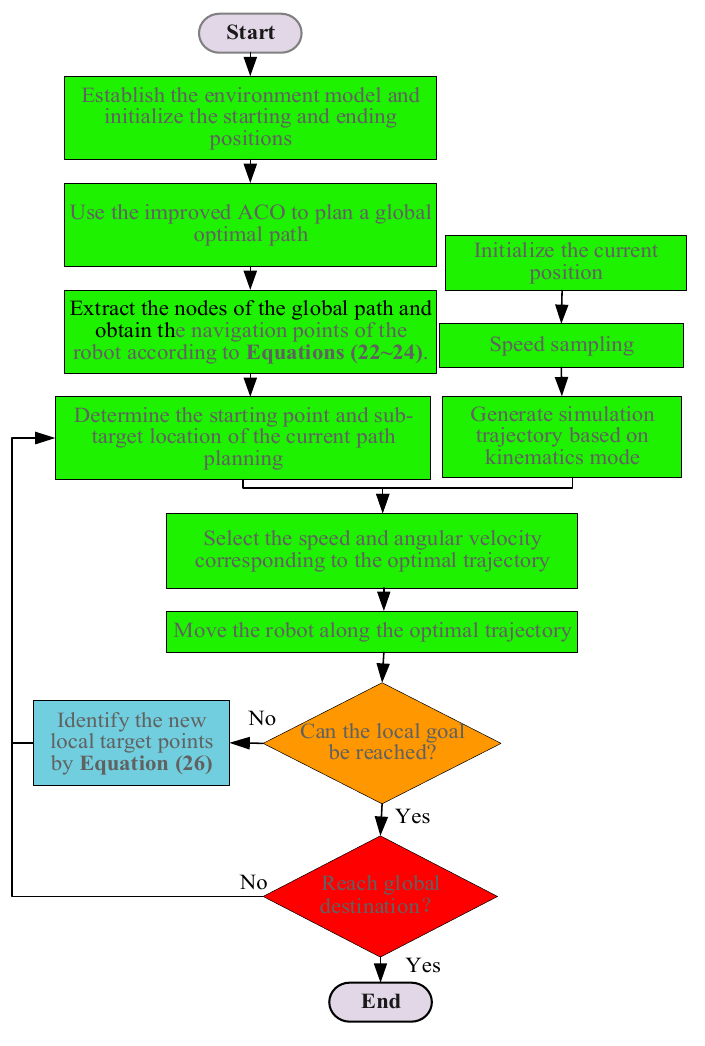
Figure 10. Flowchart of the hybrid algorithm.